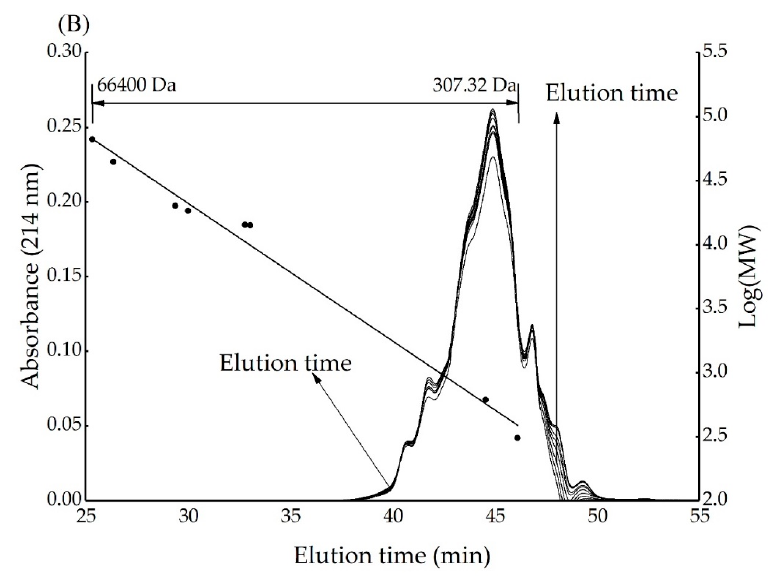
Figure A5. Effect of reaction time on molecular size of xylose–BCH MRPs ( A ) and BCH ( B ).